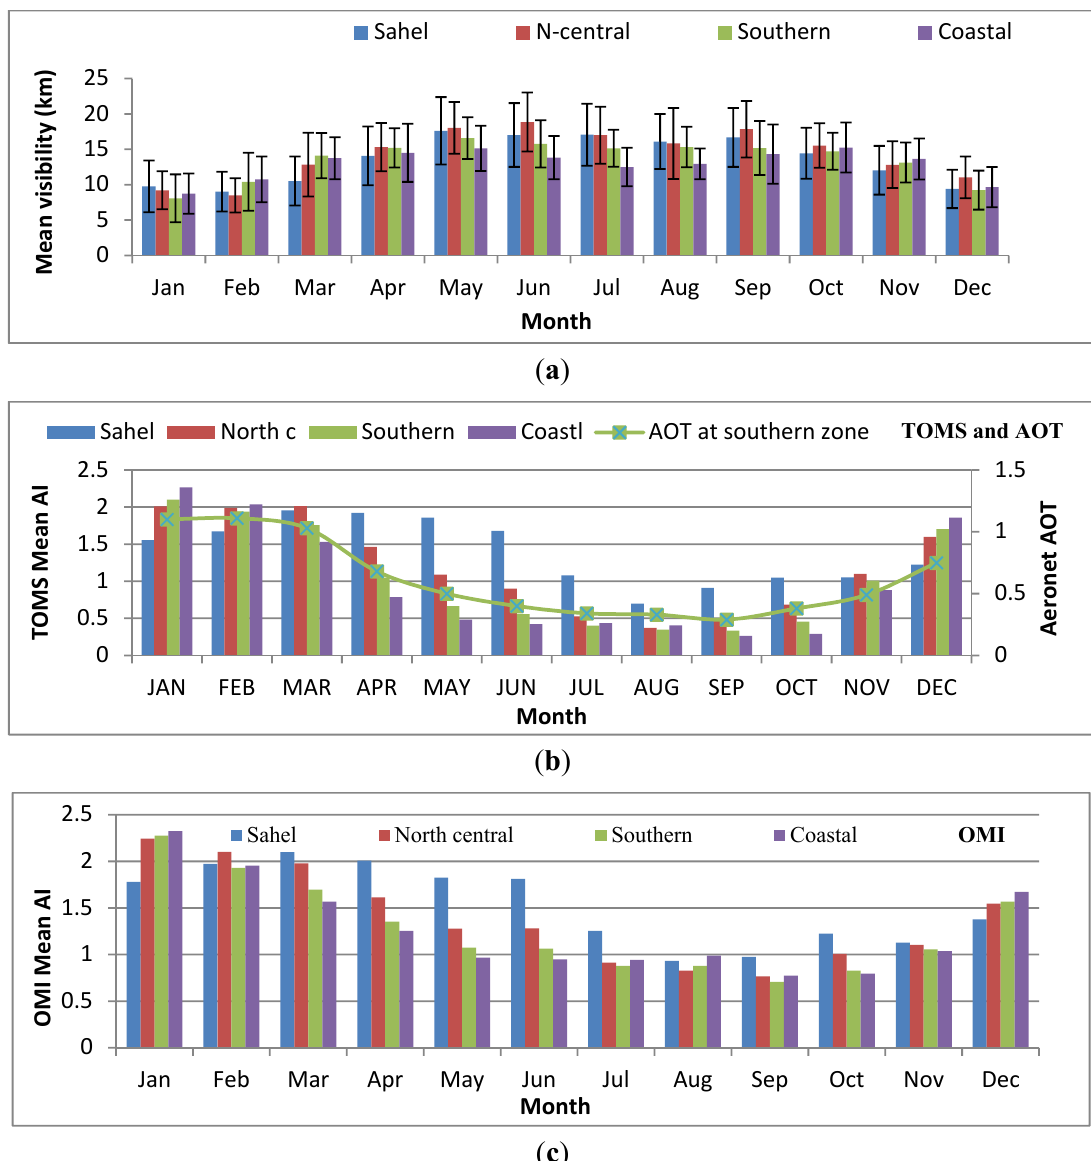
Figure 7. Display and compared annual cycle of visibility, aerosol optical thickness (AOT) and aerosol index from TOMS and OMI and AOT in Nigeria: ( a ) Visibility and AOT, ( b ) TOMS AI, ( c ) OMI